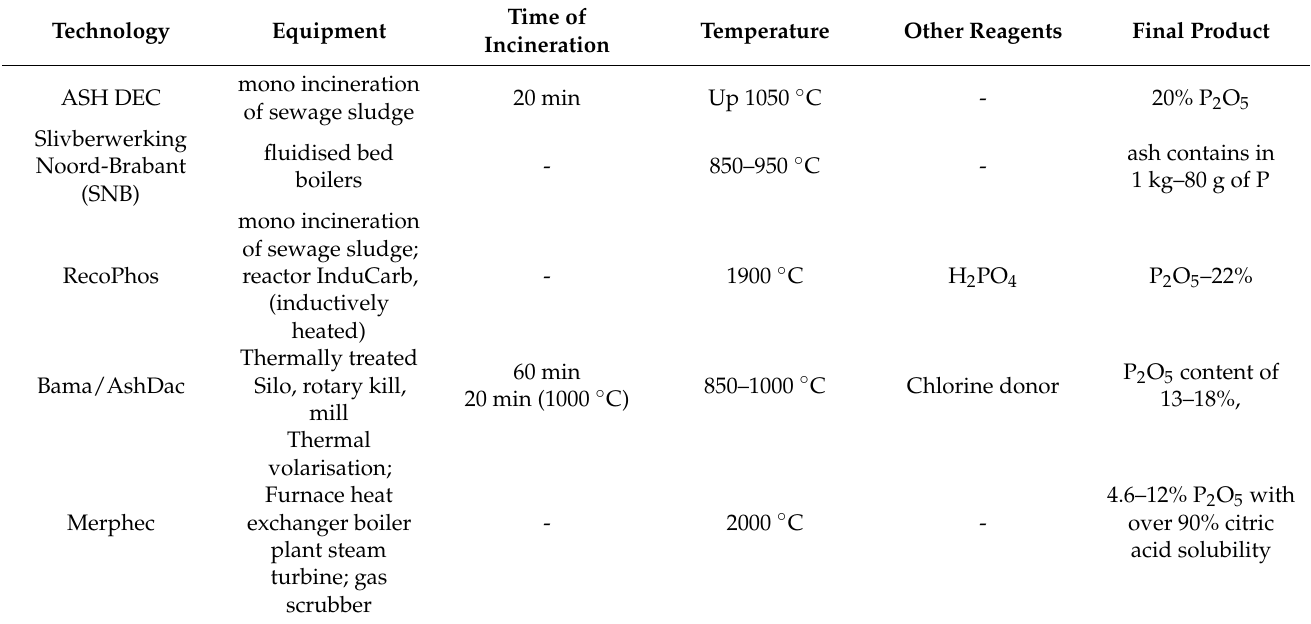
Table 3. Thermochemical methods of phosphorus recovery from SSA